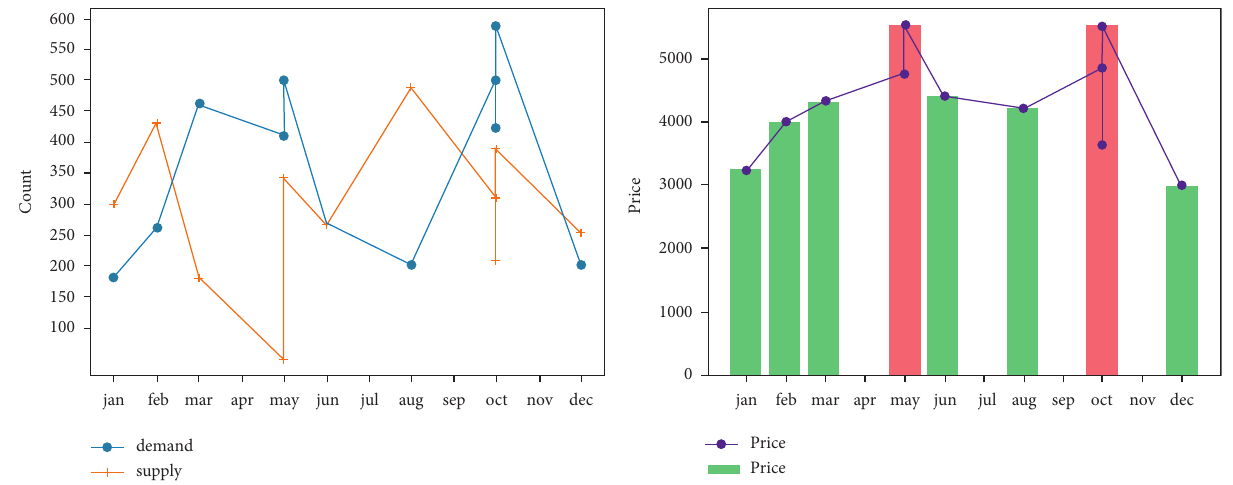
Figure 11: Supply-demand analysis for